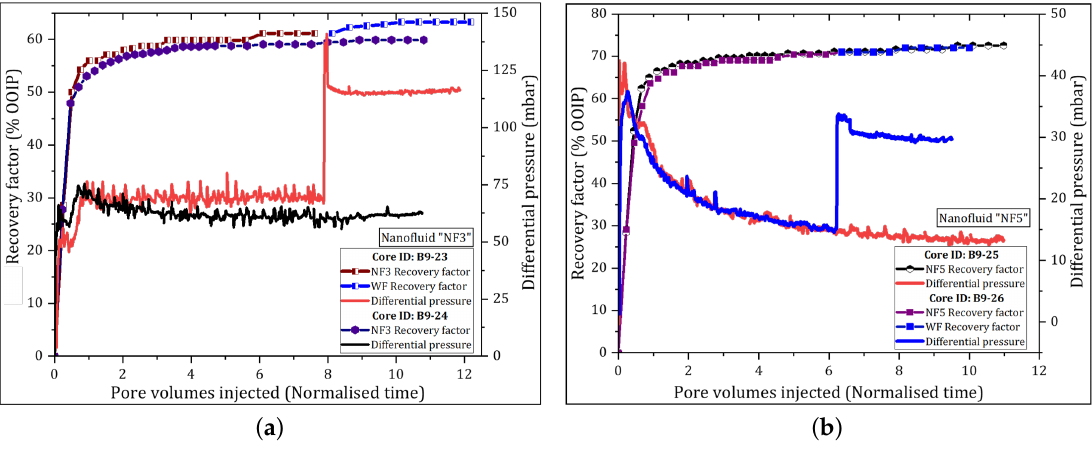
Figure 4. Secondary oil recoveries and dP versus PVs recorded throughout flooding tests. Two tests were conducted for each nanofluid type. WF was conducted only in replicate test at flow rate of 0.5 mL/min: ( a ) NF3 (dP = 65 mbar); and ( b ) NF5 (dP = 14